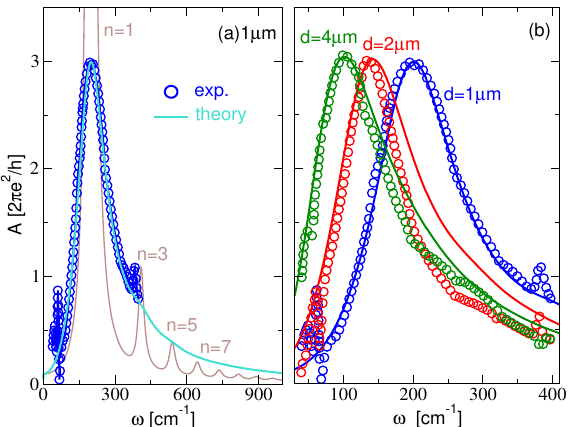
Figure 8. ( a ) Comparison of the absorption spectra A in a doped graphene ribbons array of width d = 1 µ m calculated for η intra = 1 meV (brown line) and for η intra = 15 meV (turquoise line) with the result of differential transmission ∆ T [15] (blue circles); ( b ) Comparison of the absorption spectra A in doped graphene ribbons array of widths d = 1 µ m (blue line), d = 2 µ m (red line) and d = 4 µ m (green line) with the result of the differential transmission ∆ T [15] (blue, red and green circles). Here, the intra-band damping parameter is η intra = 15 meV, the period l = 2 d and z 0 = 4 Å in all cases and the hole concentration is 1.5 × 10 13 cm − 2 ( E F = − 0.374 eV relative to Dirac